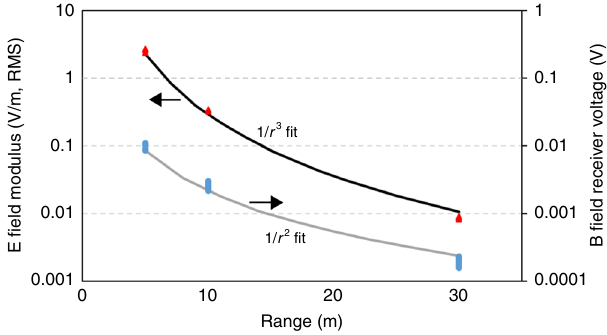
Fig. 8 Measured E and B fi eld versus range. The data points show each individual measurement and the lines are fi ts to the